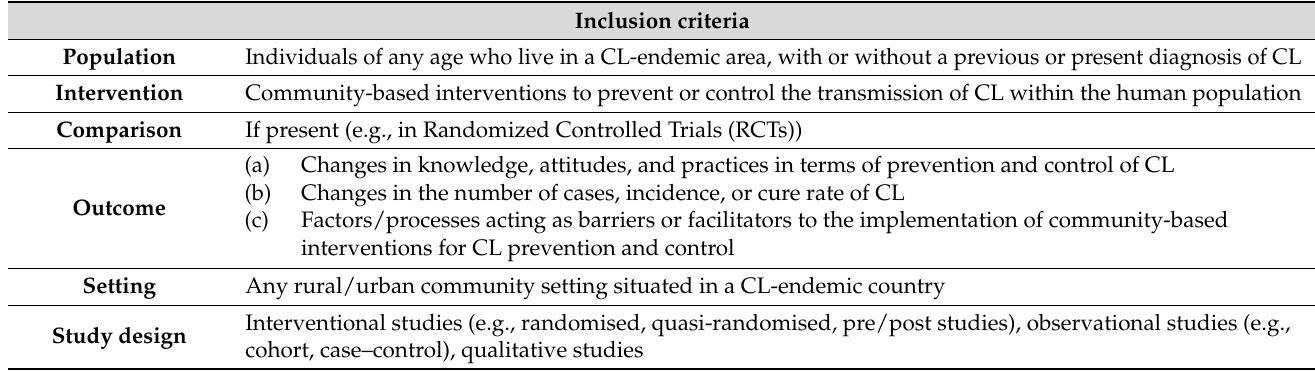
Table 1. Inclusion and exclusion criteria adopted in this review. Inclusion